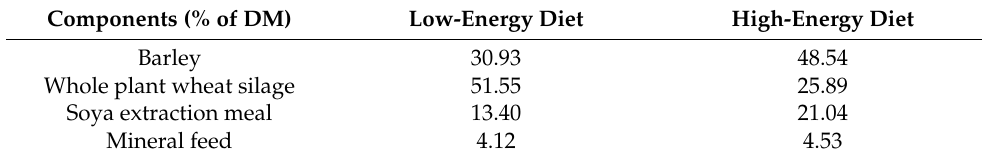
Table 3. Botanical composition of ad libitum liquid feeding in the low- and high-energy diets. Components (% of